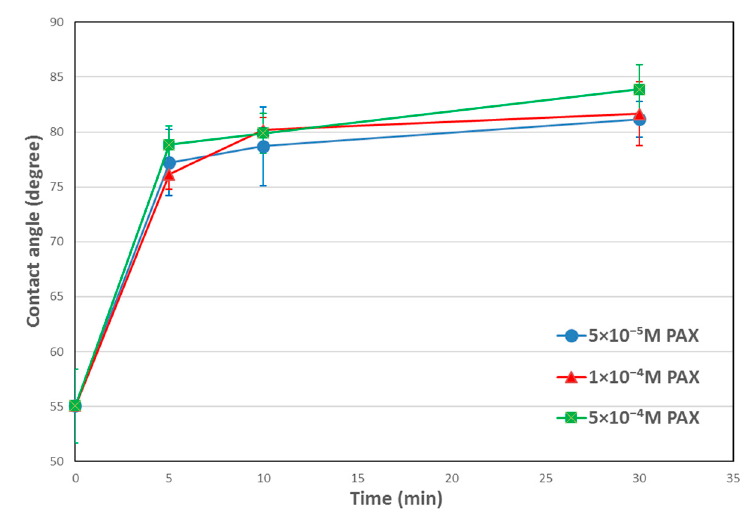
Figure 1. Contact angle results of chalcopyrite surface after contact with potassium amyl xanthate (PAX) solution of different concentrations for 5 min, 10 min and 30 min at 25 °C.